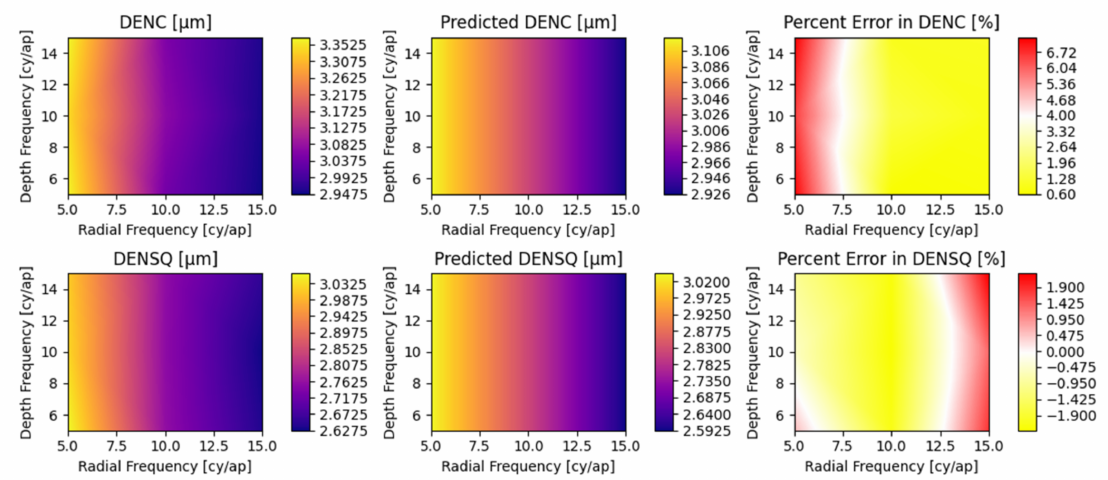
Figure A5. Radial Frequency versus depth frequency. (3 × 3 sampling matrix) ( κ = ω = δ = 0, η = 0.15, σ = 0.05, θ = 0 ◦ ).